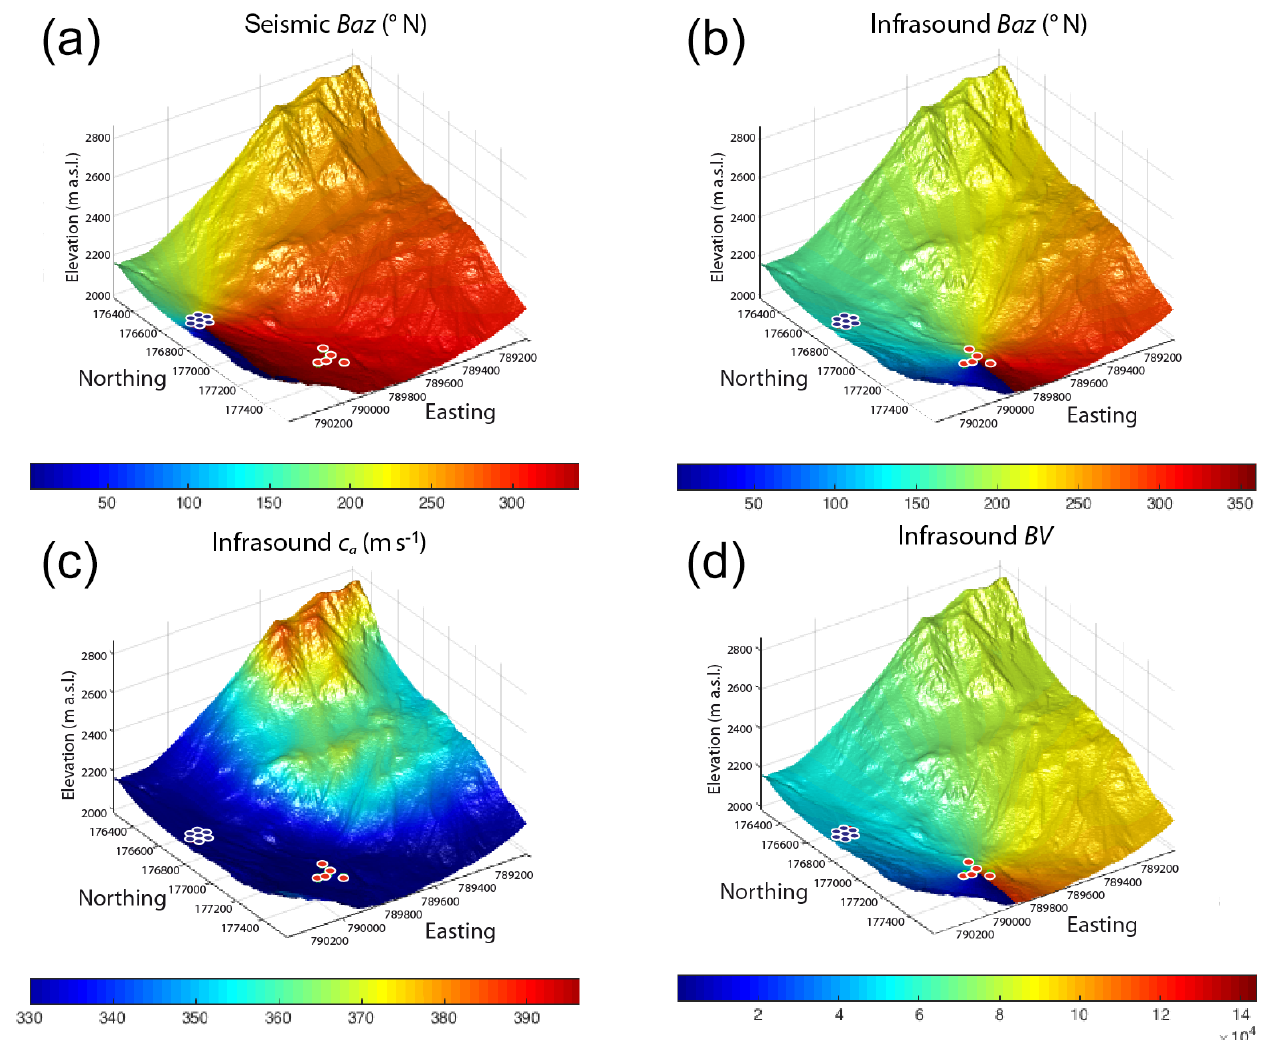
Figure 5. Theoretical values of back-azimuth at the seismic array (Baz s ( ◦ N), a ), back-azimuth at the infrasound array (Baz i ( ◦ N), b ) and apparent velocity ( c a (ms − 1 ), c ) at the infrasound array for any point source of seismic and infrasound energy located on the DEM. The product between back-azimuth and apparent velocity of the infrasound wave field is also given (BV, d ). The position of the infrasound and seismic arrays are shown by red and blue circles,